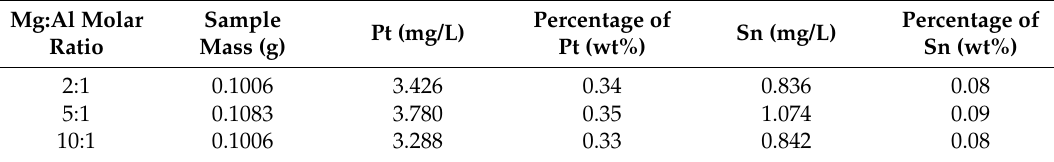
Table 1. The inductively coupled plasma atomic emission spectrometry (ICP ‐ AES) elemental analysis results revealing the amounts of Pt and Sn to be ion ‐ exchanged into the layered double hydroxide (LDH) layer.